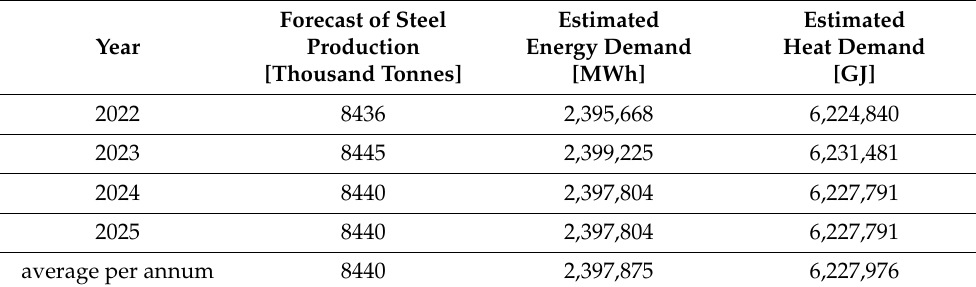
Table 2. Estimated energy and heat demand for forecasts of steel in 2022–2025 (variant 1A).